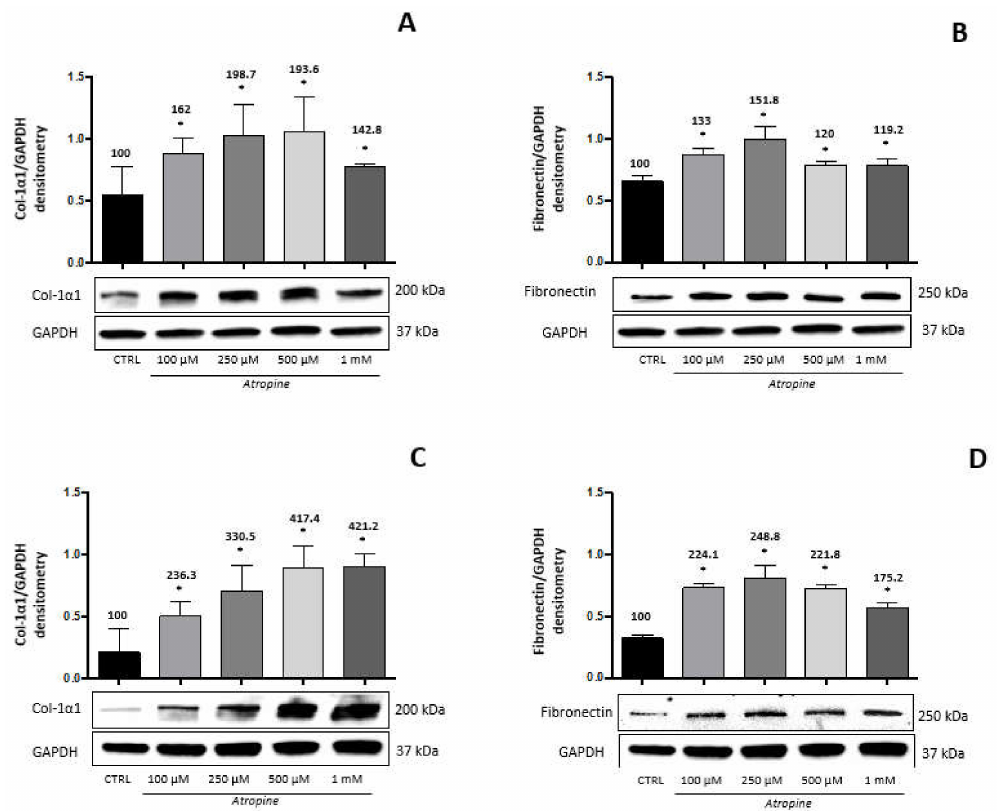
Figure 1. Atropine e ff ects on collagen and fibronectin production by HSF cells. Western immunoblot analysis of collagen type-1 α 1 (Col-1 α 1) and fibronectin in HSF lysates treated with atropine at di ff erent doses as indicated for 24 and 48 h. A representative Western immunoblot is shown at the bottom of each panel, and the quantitative analysis is reported in the histogram above. Numbers on bars indicate the percentage value with respect to the control, set at 100%. Each bar represents the average value ± SD of three di ff erent experiments: ( A ) Col-1 α 1 24 h; ( B ) Fibronectin 24 h; ( C ) Col-1 α 1 48 h; and ( D ) fibronectin 48 h. * p < 0.05 vs. CTRL. One-way ANOVA, followed by Tukey’s